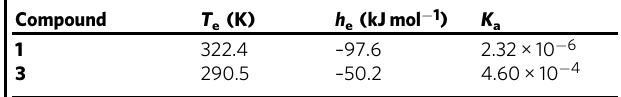
Table 1 Thermodynamic parameters of 1 and 3 obtained by fi tting the temperature-dependent CD data Compound